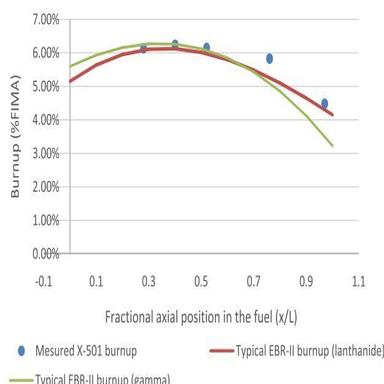
X501-G591 measured axial burnup distribution. The typical EBR-II burnup profile is reported for comparison, both as measured from a gamma ray spectrometry technique (gamma, green line) and chemical analysis from La, Tc (lanthanide, red line) . (For interpretation of the references to color in this figure legend, the reader is referred to the Web version of this article.)